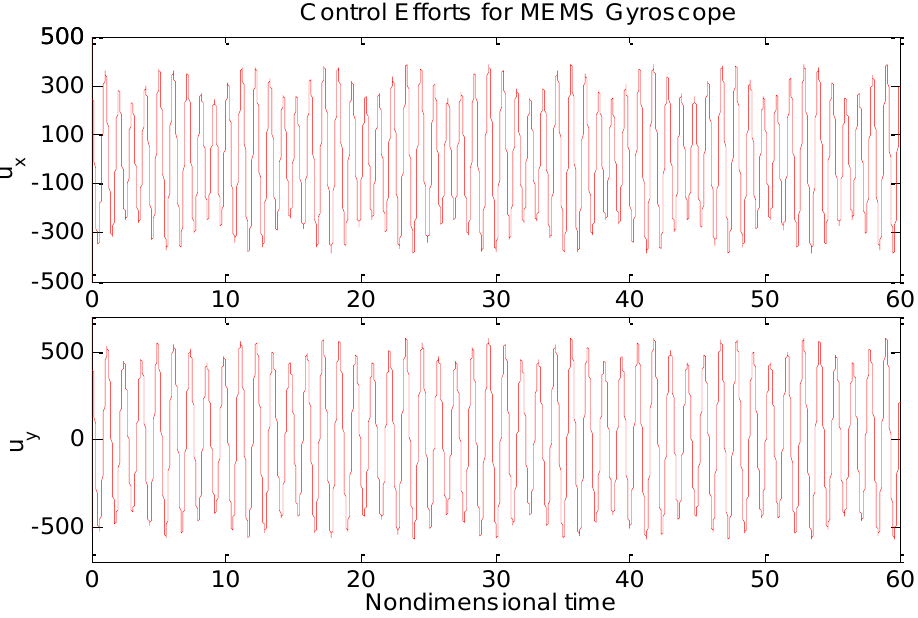
Figure 6. Control efforts for microgyroscope using ABC.